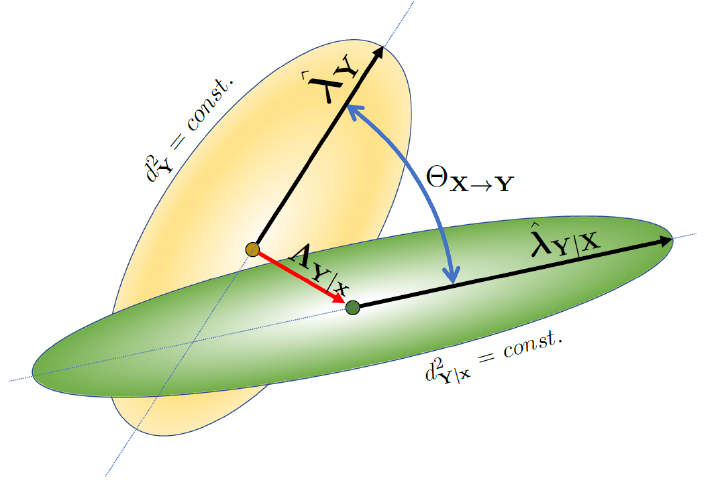
Figure 1. A pictorial representation of the effect of conditioning on the qui-probability surface of a multivariate elliptical distribution. Such surfaces are ellipsoids in a p Y -dimensional space. They are respectively described by the equations d 2 the barycentre of the ellipsoid d 2 Θ X → Y and it changes the length of such axis from